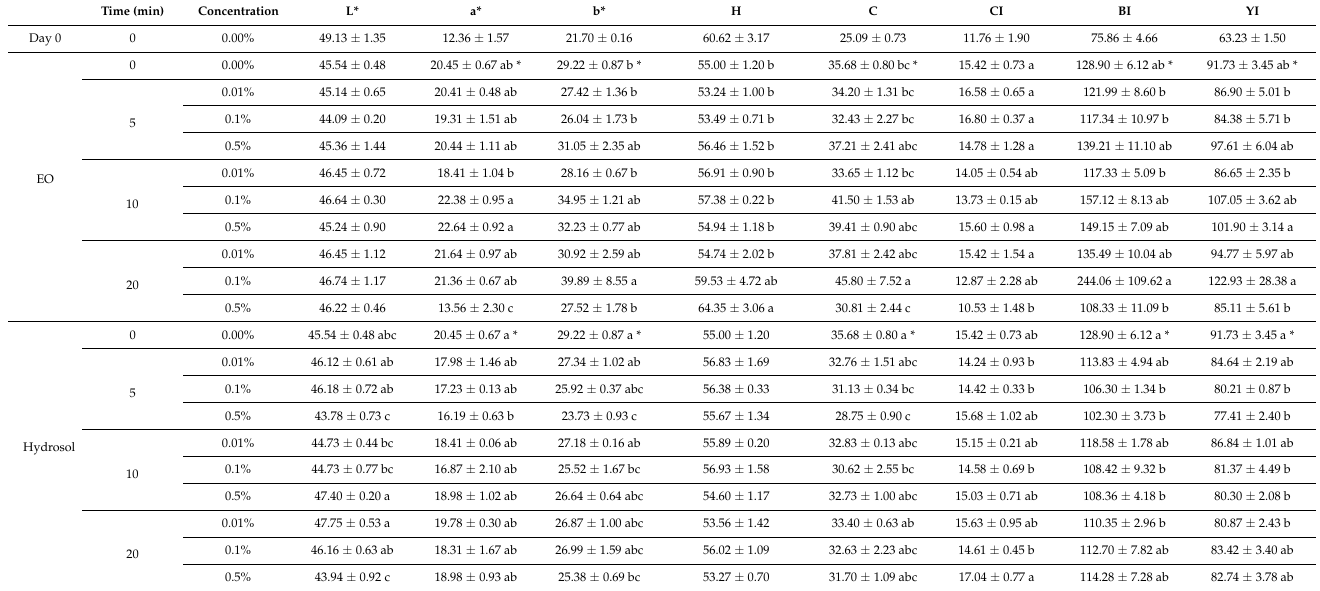
Table 3. Screening of O. dubium EO and hydrosol application effects on fresh tomato color parameters (L*, a*, b*, hue (h), chroma value (C), color index (CI), browning index (BI) and yellowing index (YI)) when stored at 11 ◦ C for 12 days. Values presented as mean ± standard error of four biological replicates per treatment. Measurements for day 0 refer to the control. In each column and for each treatment (EO and hydrosol), significant differences ( p < 0.05) are indicated with different Latin letters. For control (0.00%), the asterisk (*) indicates the difference ( p < 0.05) on the initial and final days (day 0 and day 12, respectively).